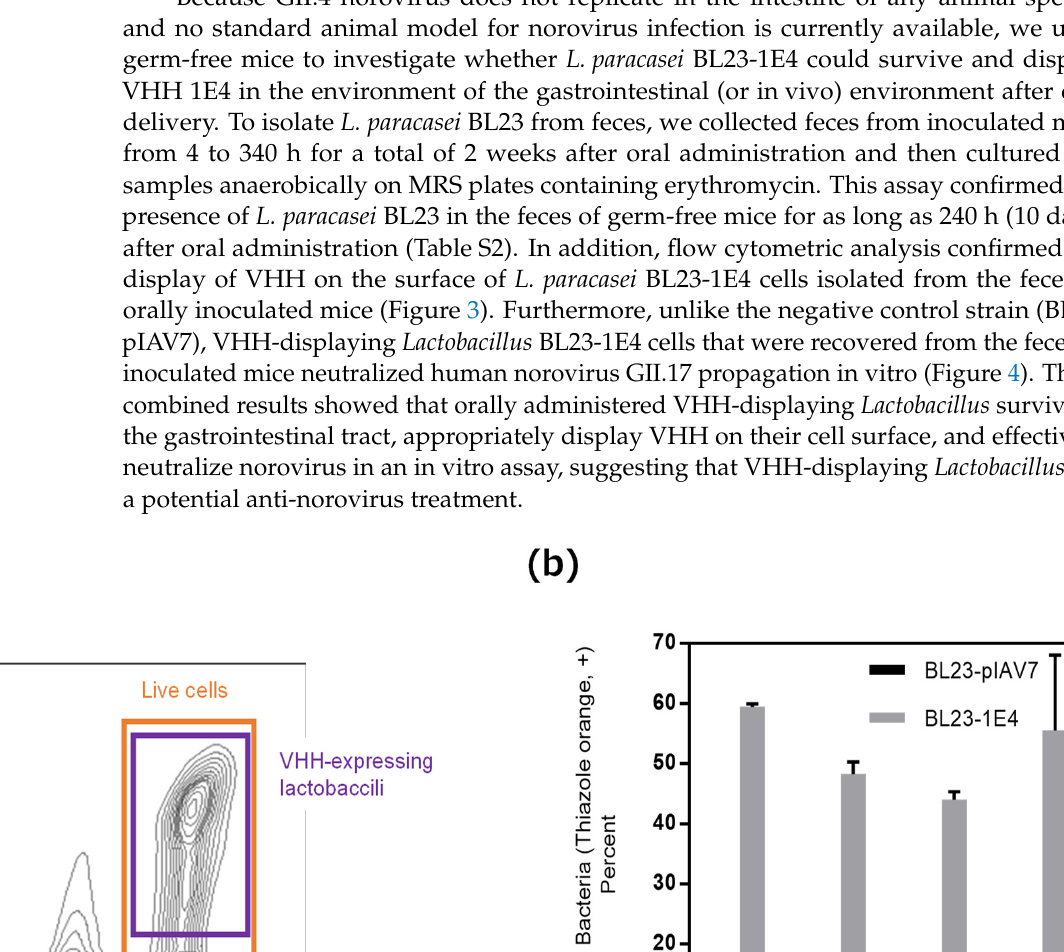
Figure 4. Neutralization of norovirus GII.17 in vitro by Lactobacillus BL23-IE4 that was collected from the feces of germ-free mice orally inoculated with 1E4 nanobody-displaying Lactobacillus (BL23-IE4 ) . We incubated 2 × 10 6 genome equivalents of GII.17 (Kawasaki308) human norovirus with 3 × 10 6 cells of L. paracasei BL23-pIAV7 or BL23-1E4 for 2 h before using them to inoculate human intestinal epithelial cells. After inoculation, the cultures were incubated for 48 h in the ) ) )